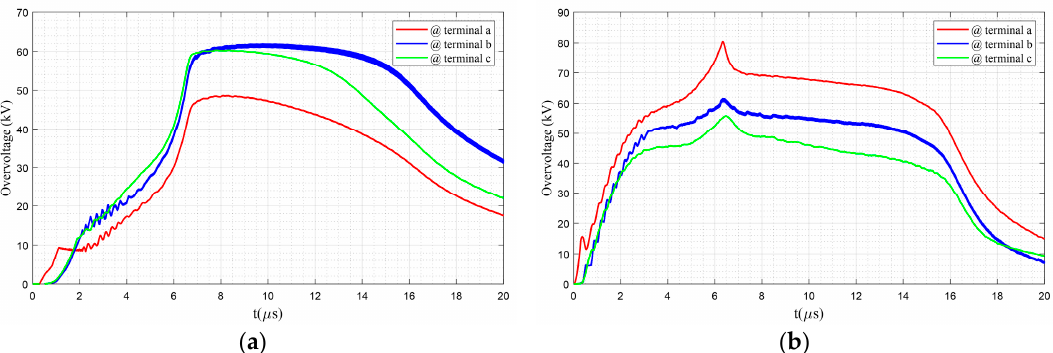
Figure 11. Performance of surge arrester when direct lightning is applied on ( a ) the intermediate pole adjacent to the transformer and ( b ) the transformer pole.